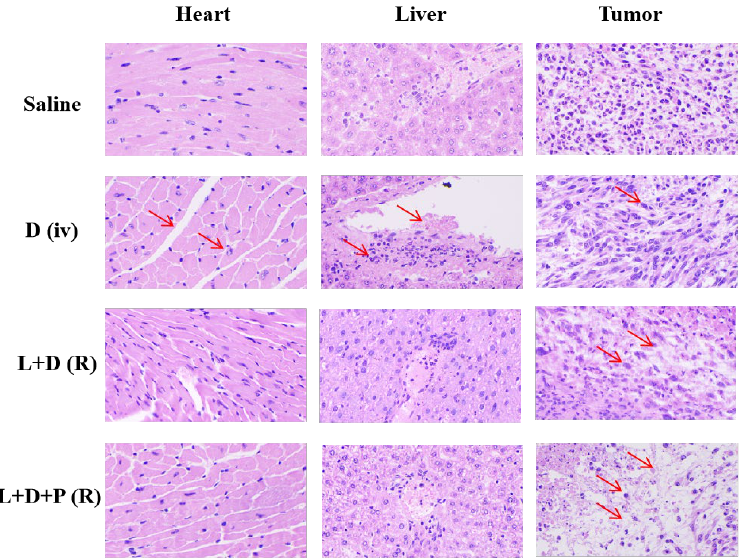
Figure 5. H&E-staining images of heart, liver, and tumor slices (D (iv) refers to DOX (iv), L + D (R) refers to LBP + DOX (R), L + D + P (R) refers to LBP + DOX + PPY (R + NIR)). The place indicated by the red arrow is the site of injury or lesion.